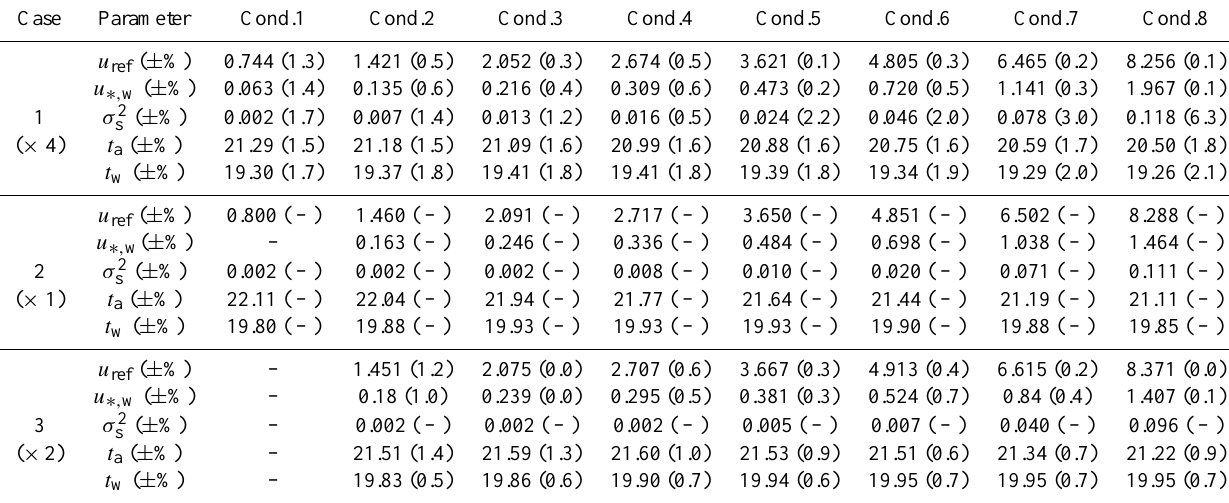
Table 2. Reference velocities, u ref (ms − 1 ), friction velocities, u ∗ , w (cms − 1 ), mean square slope, σ 2 s , air temperature, t a ( ◦ C), water tem- perature, t w ( ◦ C) mean values and % standard deviations as quantified in the Aeolotron facility for case 1: clean surface experiments; case 2: surface covered with 0.033mgL − 1 Triton X-100; and case 3: surface covered with 0.167mgL − 1 Triton X-100, at eight different wind speed conditions. The number of replicates used for each case is given in